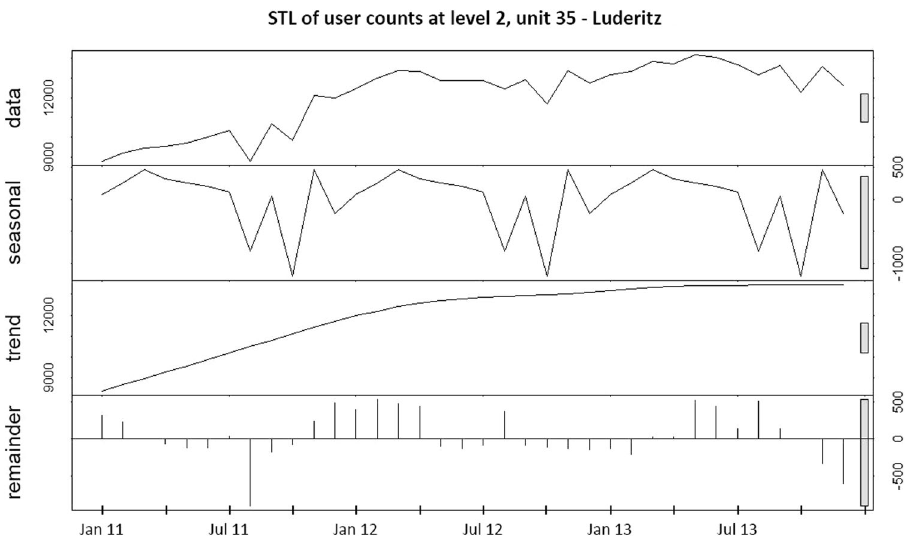
Fig. 4 Result of STL decomposition of the daily average of user counts per month for a level 2 administrative unit, Luderitz, using the corresponding best CDR distribution method, i.e. Tower Ranges. STL enables the separation of the seasonal component and the trend from CDR user counts (data) whilst leaving a remainder.